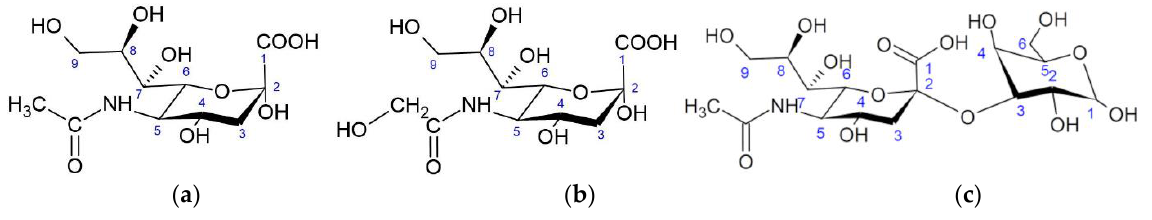
Figure 1. Structure of sugar receptors of EBL ligands: ( a ) N -acetylneuraminic acid (Neu5Ac), ( b ) N -glycolylneuraminic acid (Neu5Gc), ( c ) α (2 → 3) Sialyllactose. The linkage configurations of sialic acids are α(2,3) or α(2,6) with galactose or N -acetylgalactosamine and α(2,8/9) in polysialic acids. These bonds are c reated by specific